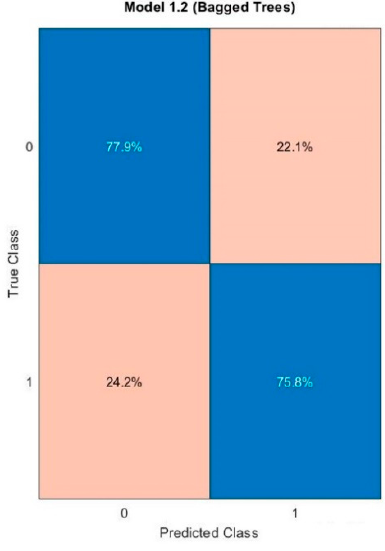
Figure 4. ROC curve of the fit of the ignition model.